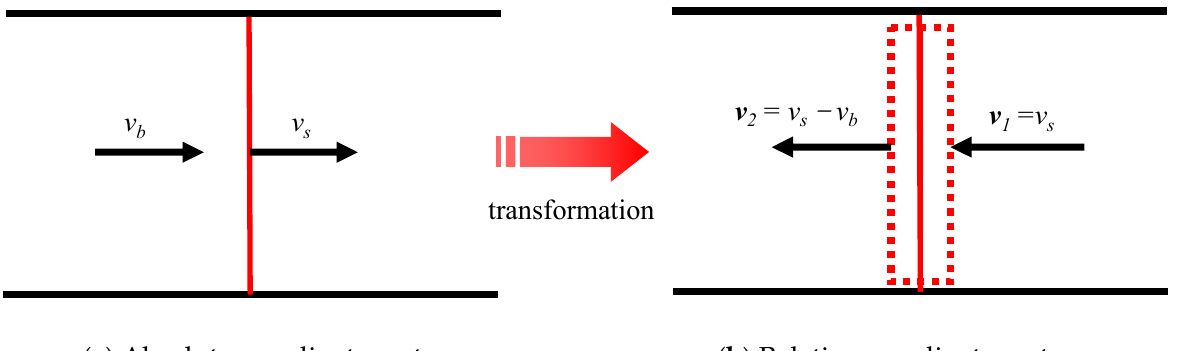
Figure 7. Transformation of coordinate system of wave front.